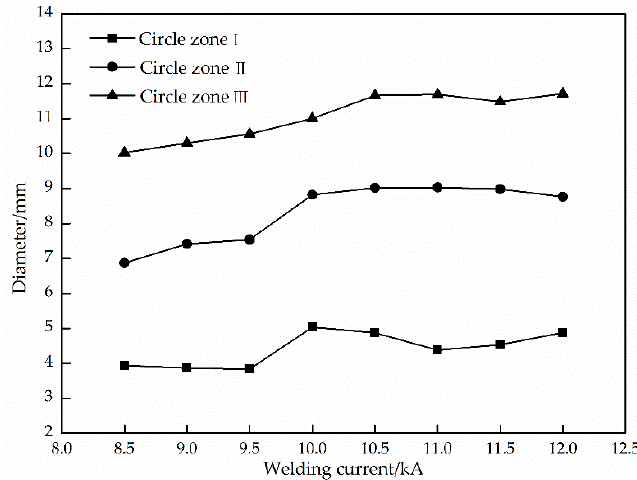
Figure 6. Effect of the welding current on sizes of three feature zones on the weld appearance.